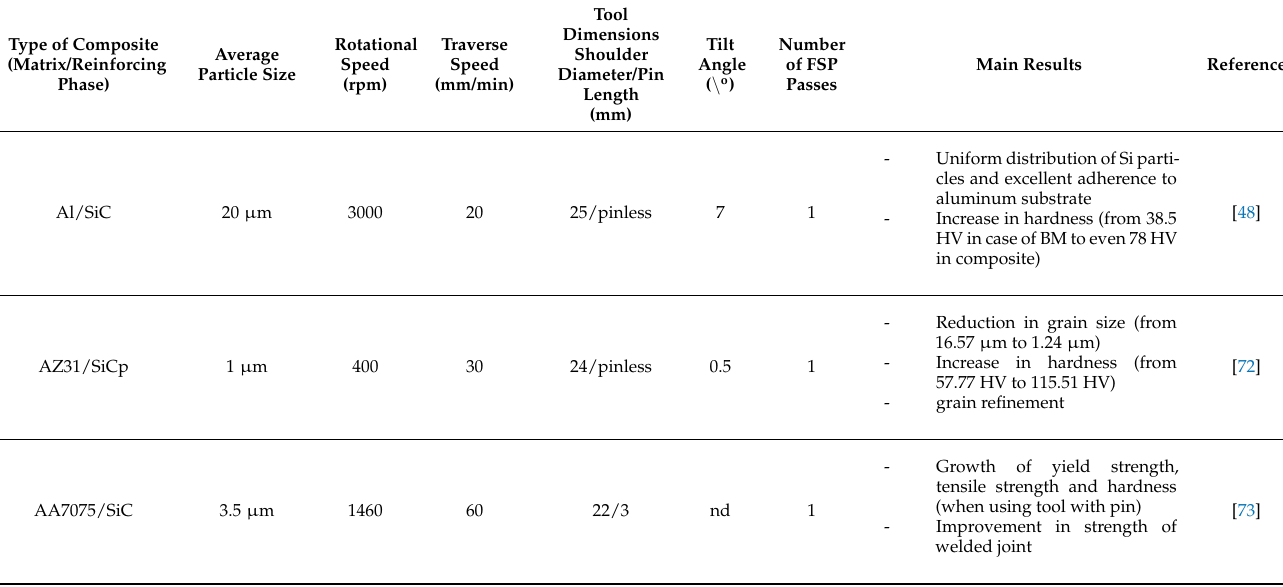
Table 4. List of cited